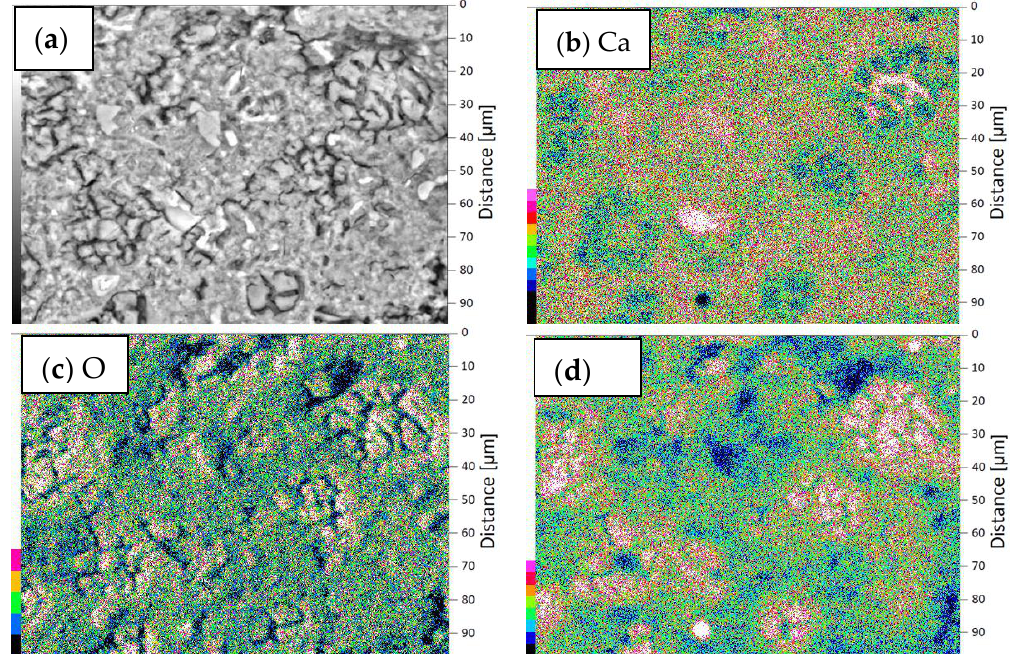
Figure 17. EDX mappings of chemical elements in the subsurface layer of the substrate of the reference sample: ( a ) area of the performed distribution, ( b ) images of Ca incidence, ( c ) images of O incidence, ( d ) images of Si incidence. Materials 2020 , 13 , x FOR PEER REVIEW